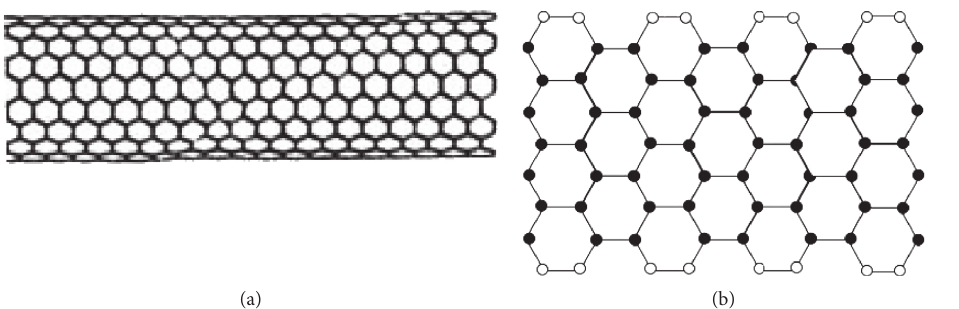
Table 5: The cardinalities of f